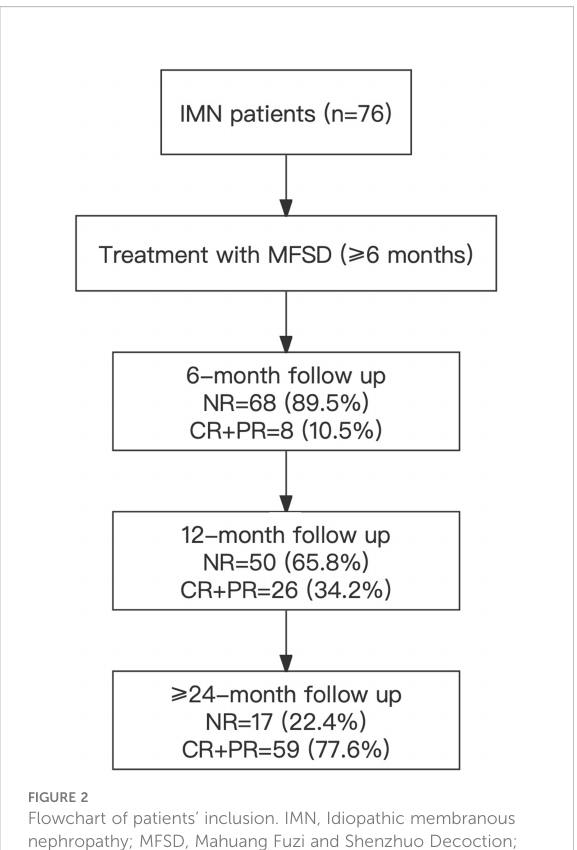
FIGURE 2 Flowchart of patients ’ inclusion. IMN, Idiopathic membranous nephropathy; MFSD, Mahuang Fuzi and Shenzhuo Decoction; NR, No remission; CR, Complete remission; PR, Partial